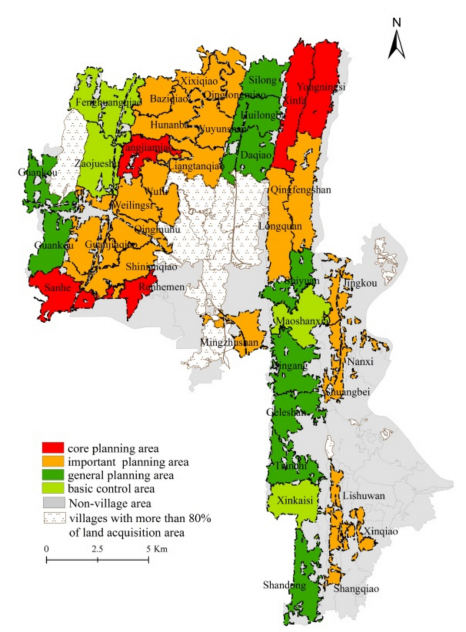
Figure 5. Results of village